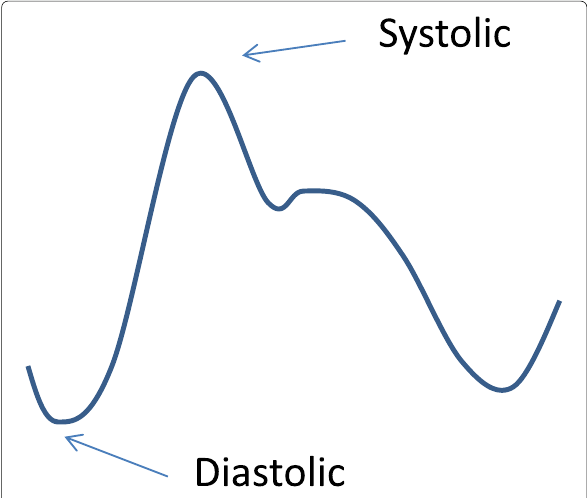
the user, in conjunction with the synchronously measured, unaltered ABP measurements also obtained from the